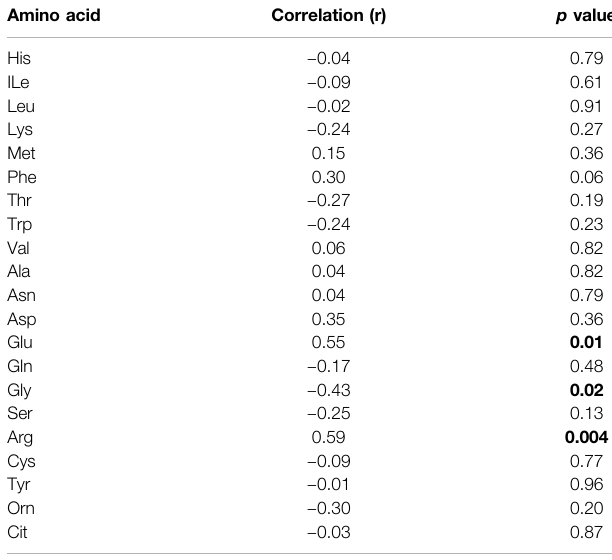
The bold values indicate statistically signi fi cant